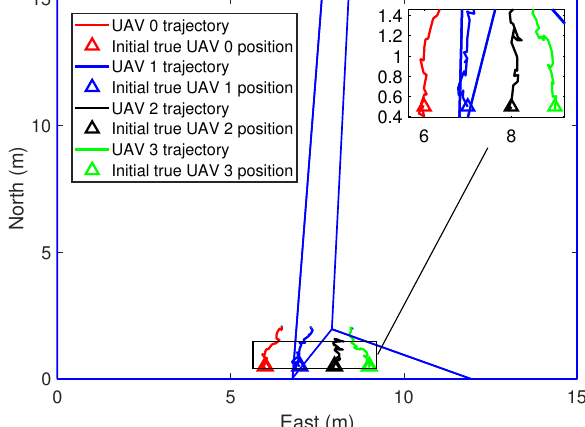
Figure 4. The process of coverage task performing, k = 20 s.